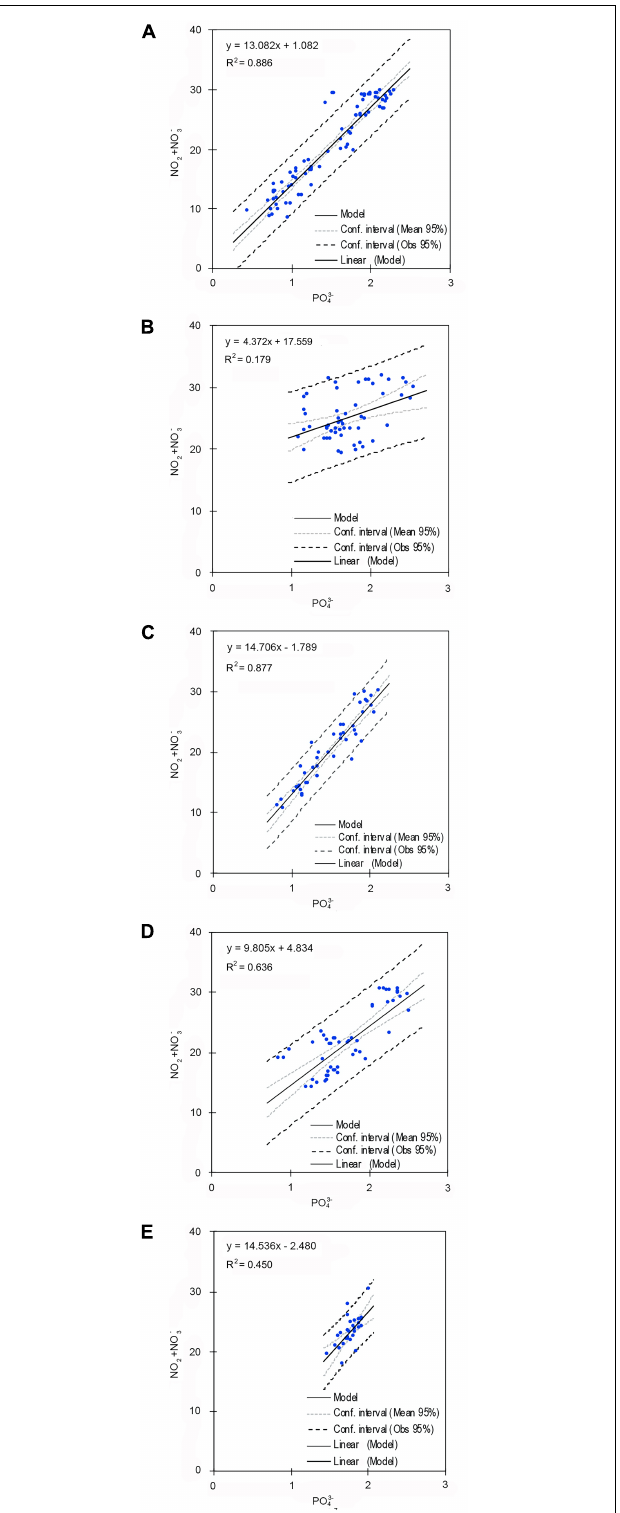
FIGURE 12 | Correlation between nitrate + nitrite and phosphate for each sub-systems sampled: Area (A) 1, Area 2 (B) , Area 3a (C) , Area 3b (D) , Area 4 (E)